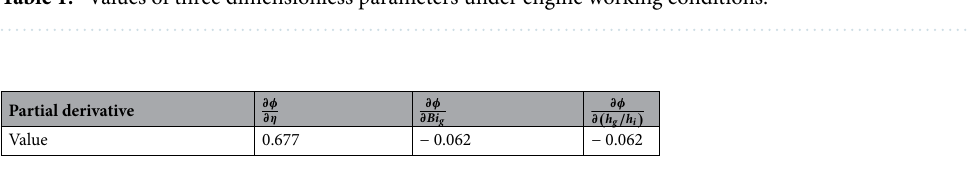
Table 1. Values of three dimensionless parameters under engine working conditions.